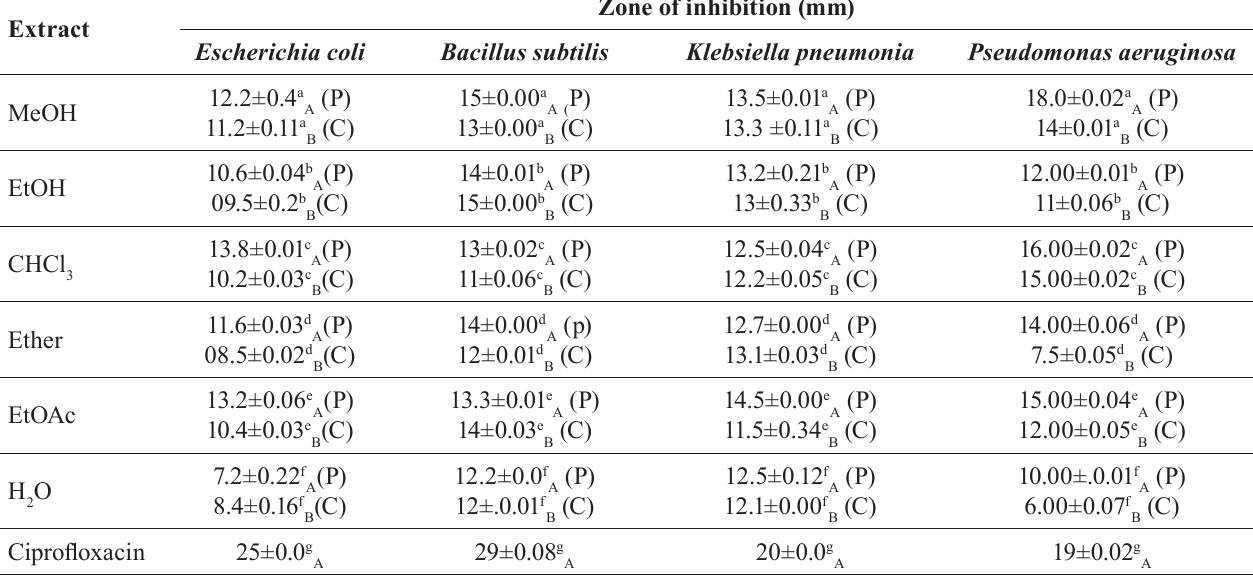
TABLE IV - Antibacterial activity of extracts from two varieties of ginger Extract